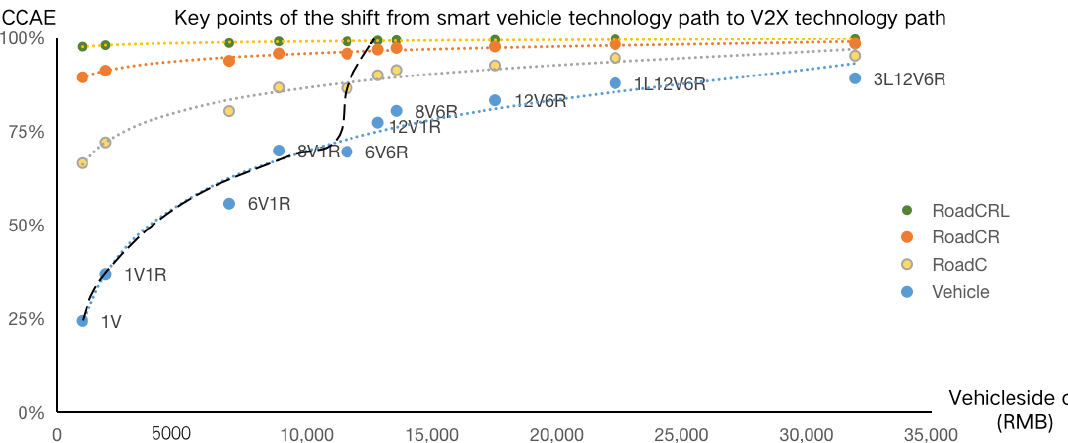
Figure 6. Comprehensive collision avoidance effectiveness and vehicle-side cost of typical “atomic” technology combinations.